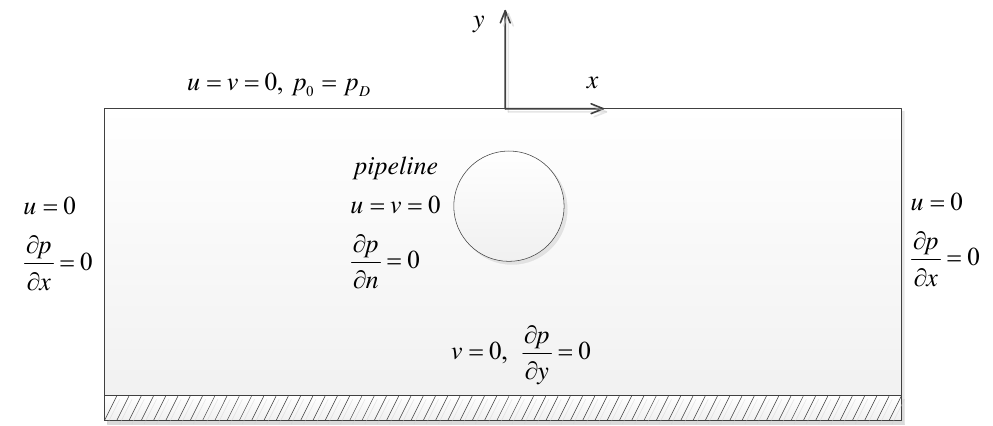
Figure 2. Boundary conditions of the soil consolidation